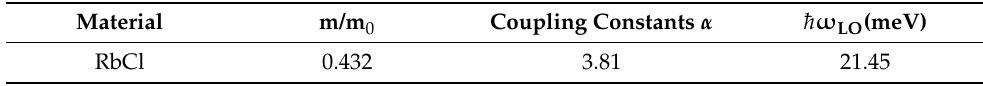
Table 1. Values of various parameters used in calculations.